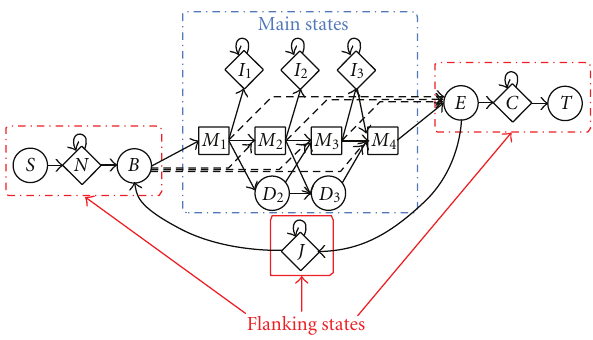
Figure 1: Plan7 architecture used by HMMER [3].